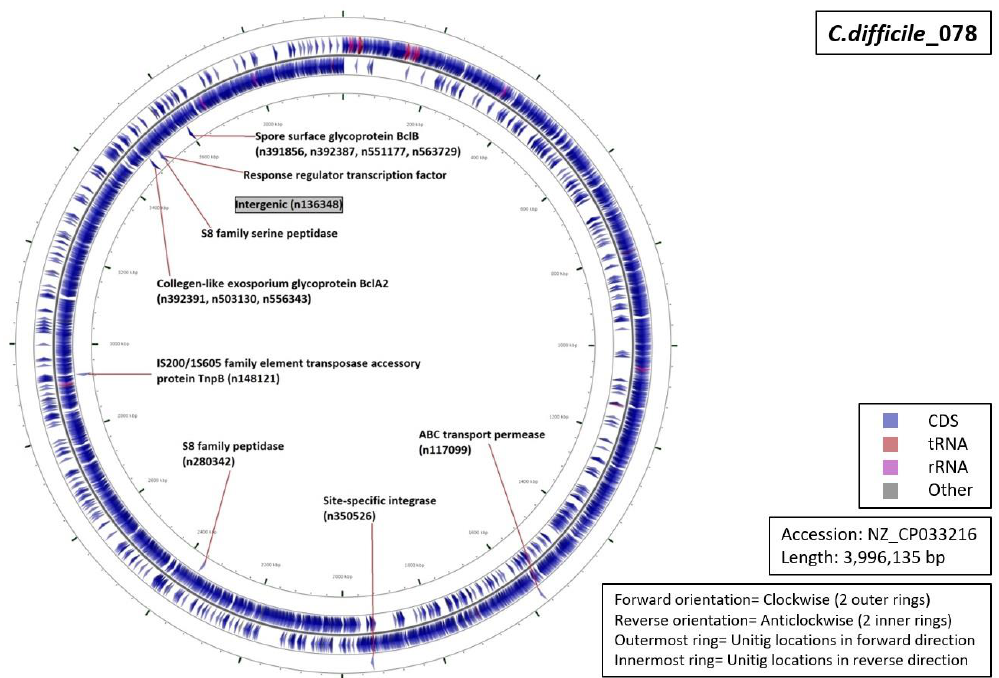
Figure 7. Functional annotation and location of DBGWAS markers on the reference genome of C. difficile RT027. Diagnostics 2020 , 10 , x FOR PEER REVIEW